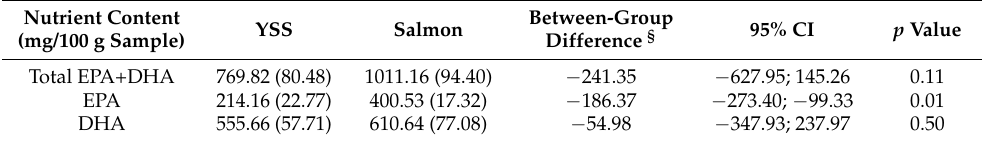
Table 6. EPA+DHA content of YSS as compared with salmon ( n =